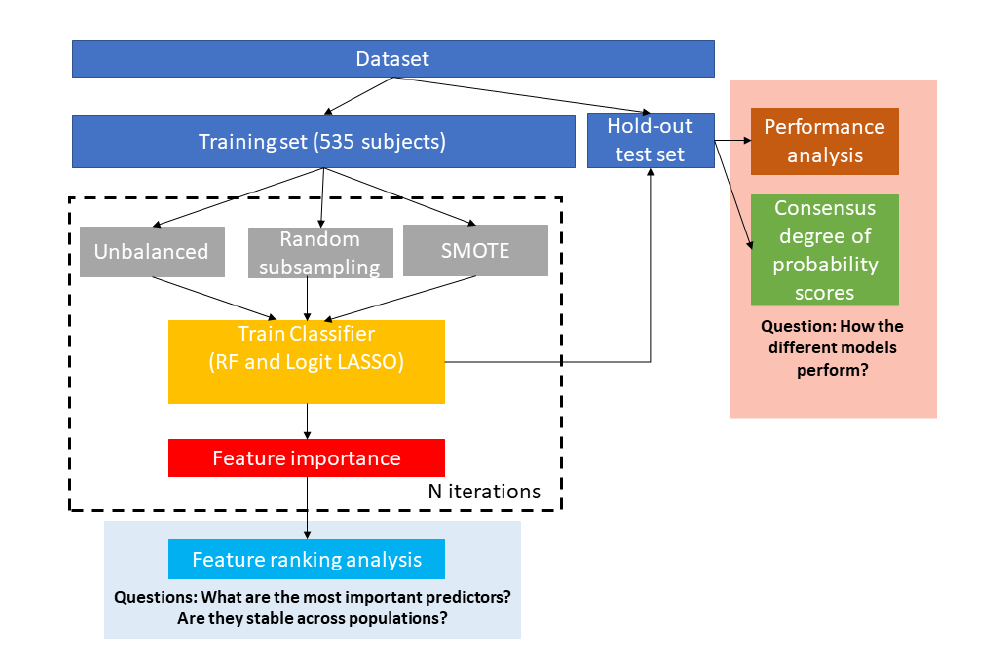
Figure 1. Overview of the proposed